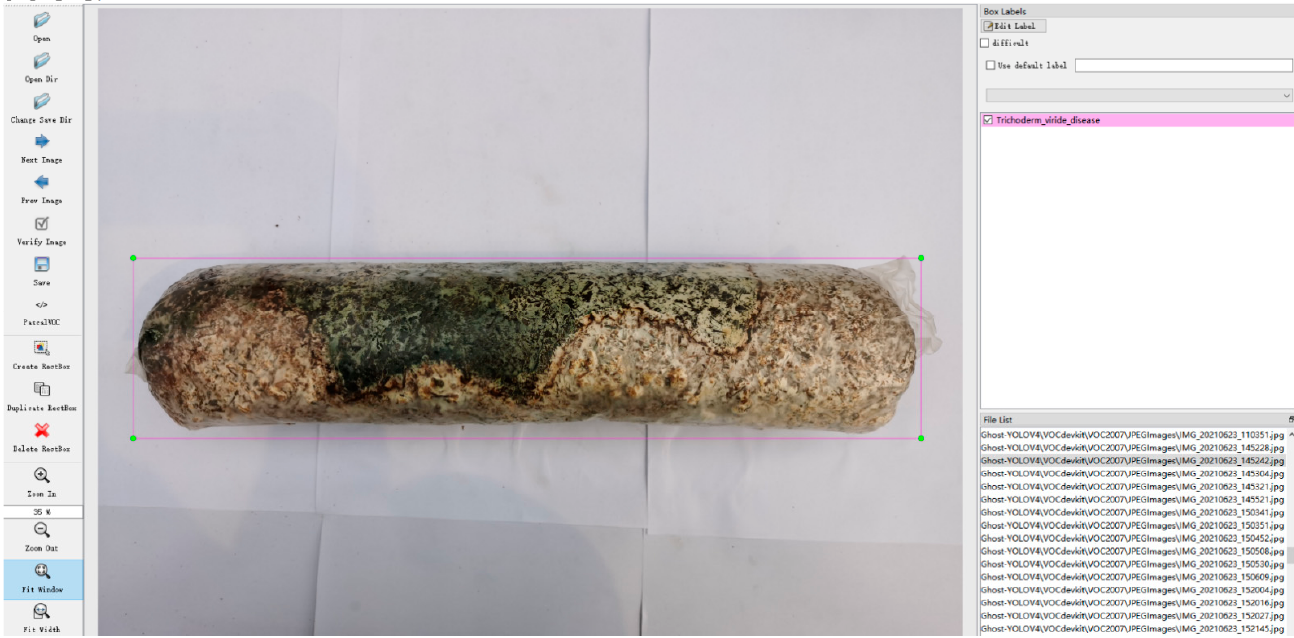
Figure 1. Example of Lentinula edodes log sundry bacteria contamination sample. ( a , b ) are Asper- gillus flavus-contaminated Lentinula edodes logs; ( c , d ) are Trichoderma viride-contaminated Len- tinula edodes logs; ( e , f ) are Neurospora-contaminated Lentinula edodes logs; ( g ) and ( h ) are nor- mal Lentinula edodes logs;